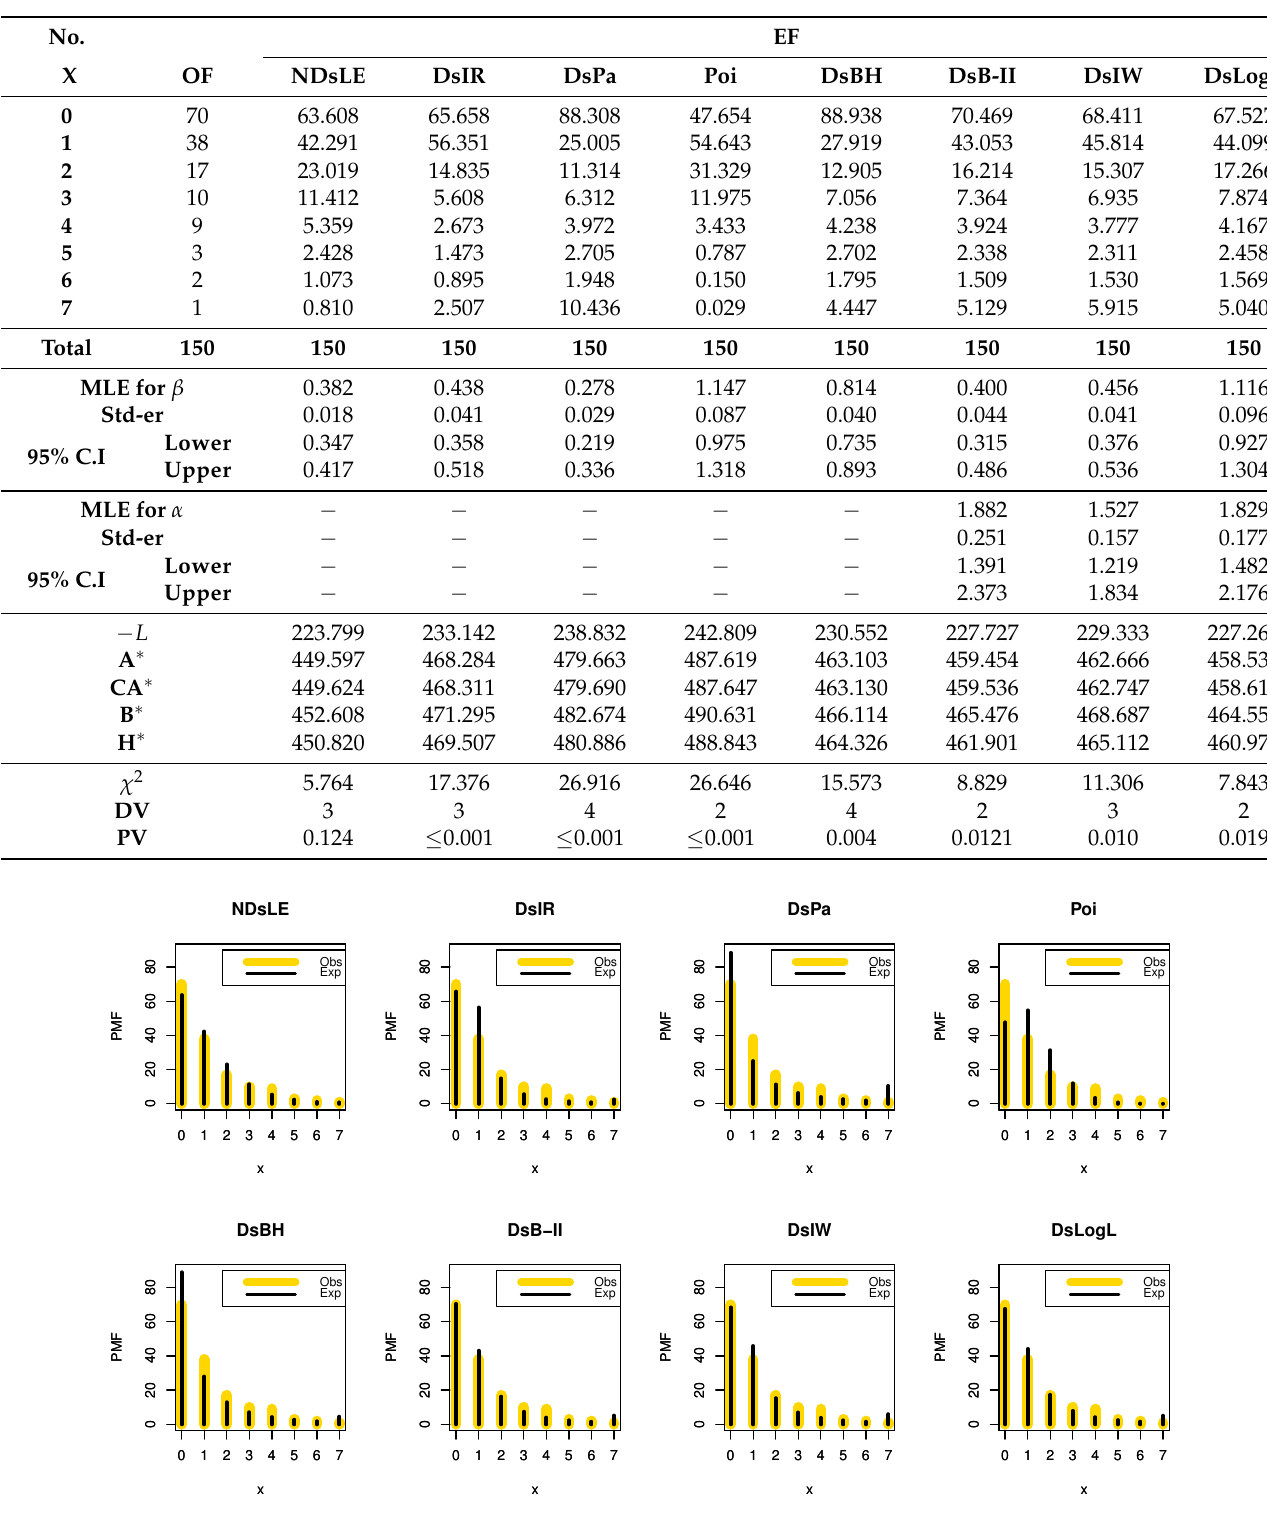
Figure 7. The empirical PMFs plots for data set